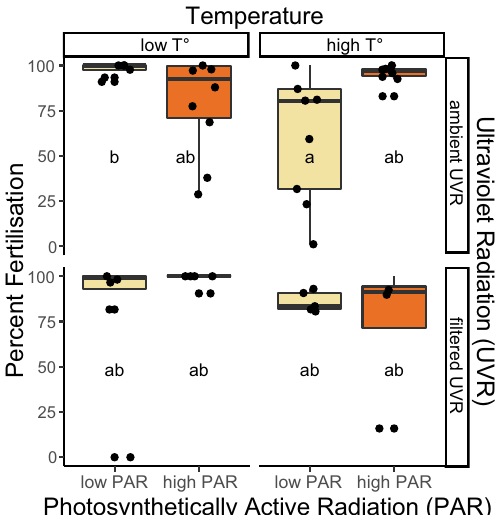
Figure 4. Fertilisation success was directly impacted only by temperature, with a reduction in percent fertilisation at high temperatures. UVR and PAR had significant interactive effects with temperature but did not show any direct effect on fertilisation. Treatments that share the same letter are not significantly different from each other.